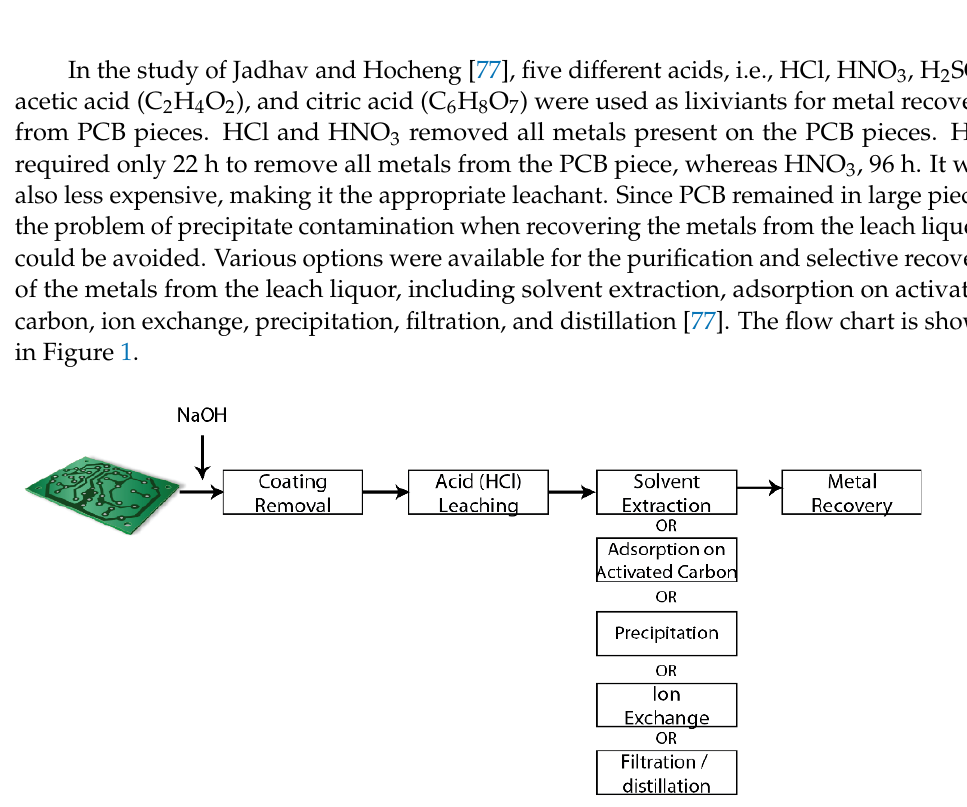
Figure 1. Recovery of PCB metals based on hydrometallurgy with acid leaching .